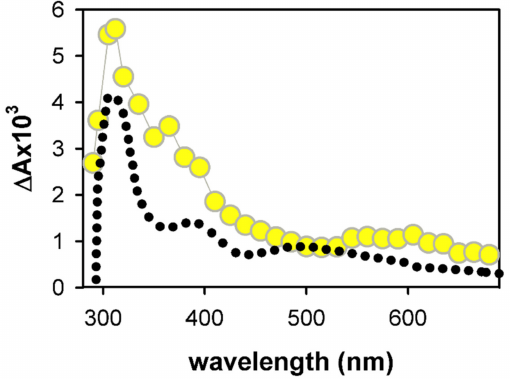
Figure 8. Comparison of the transient absorption spectrum determined for (AG 4 A) 4 /K + at 10 ms (yellow circles) with that reported for monomeric (G-H1) • (black dots)